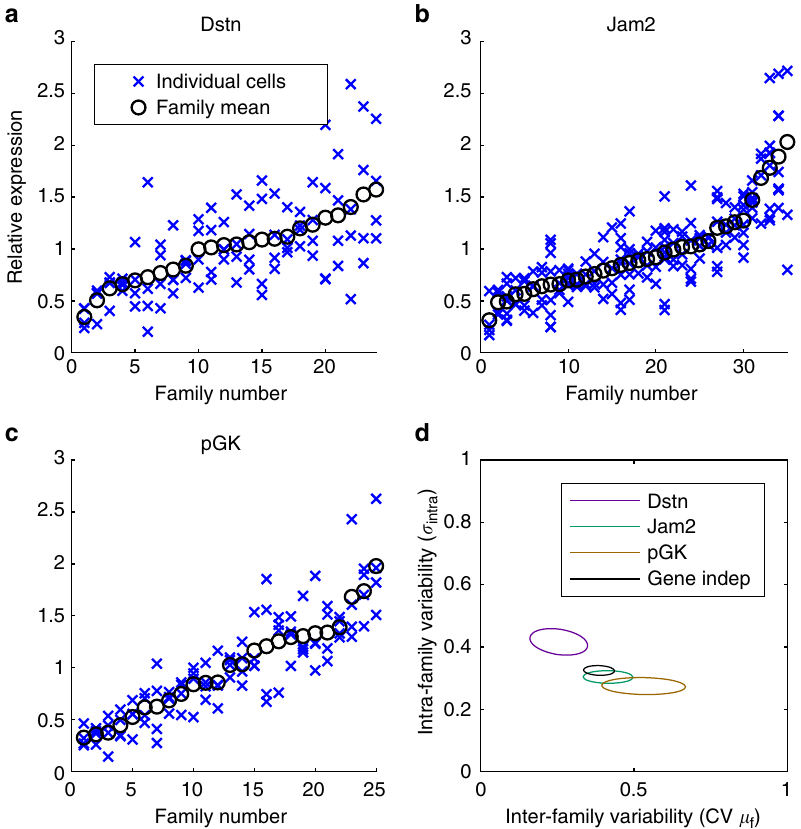
Fig. 6 Spread and multi-generational memory of transcriptional levels. a – c Distribution of transcriptional reporter levels in different families. For each family, crosses represent averaged luminescence levels from three frames preceding nuclear envelope breakdown in individual cells. Circles represent the mean of the family. d Posterior distributions of the parameters from the Bayesian hierarchical model for family data (see Methods). The inter-family variability represents the CV of family means ( μ f ), which is calculated from m and s , and the intra-family variability is represented with σ 2 represent posterior means ± SD. The black ellipse represents the gene-independent model, where the parameters of the model were assumed to be the same for all three